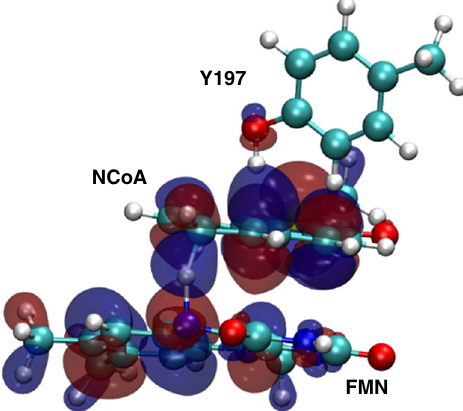
Fig. 9 Highest occupied molecular orbital (HOMO) of the transition state for the hydride transfer from FMN to NCoA. The HOMO is delocalized over both ring systems and the proton is located between N5 of FMN and C6